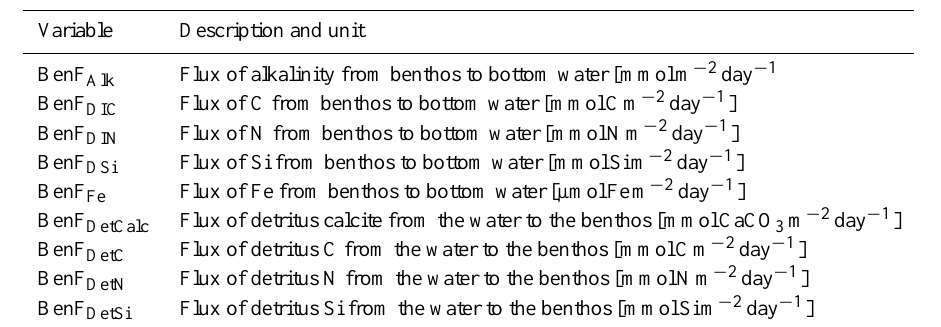
Table A5. Benthos variables.